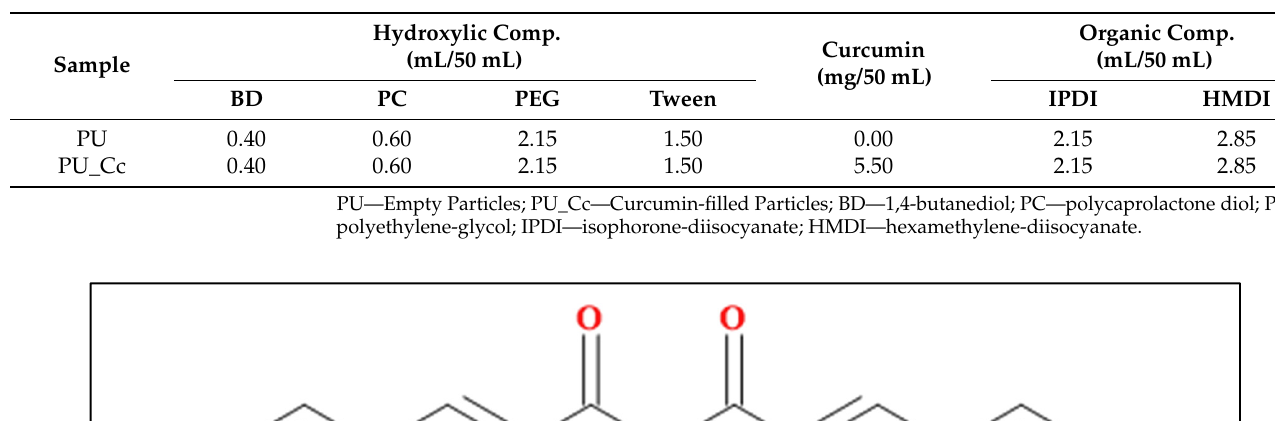
Table 1. The ratios between the raw materials.